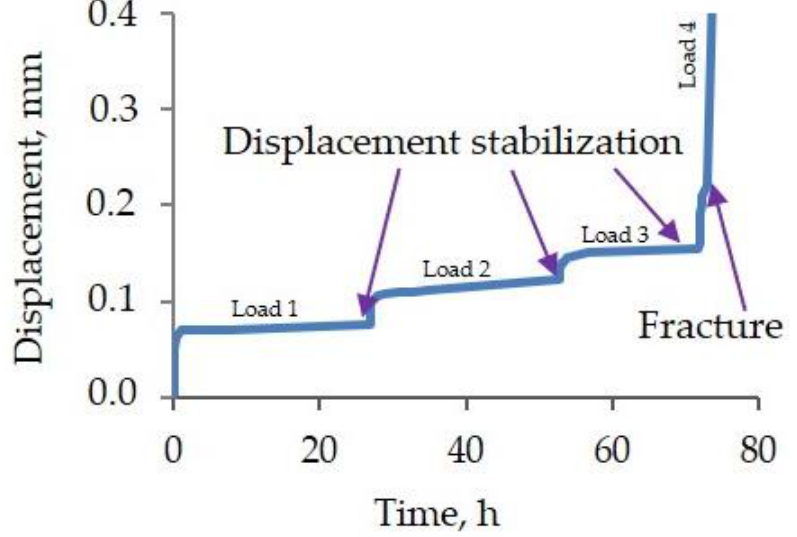
Figure 5. Creep test under incremental stepwise load.